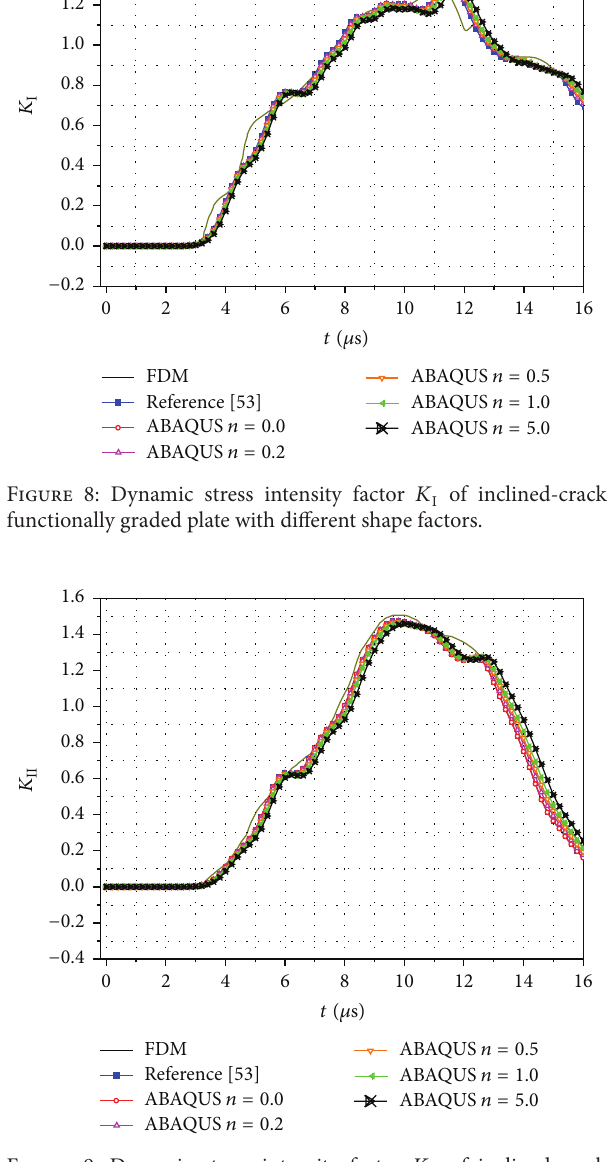
Figure 9: Dynamic stress intensity factor 𝐾 II of inclined-crack functionally graded plate with different shape